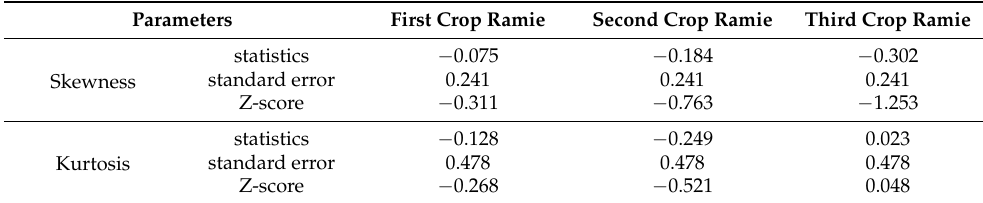
Table 4. Normal distribution test results of three crops of ramie. Parameters